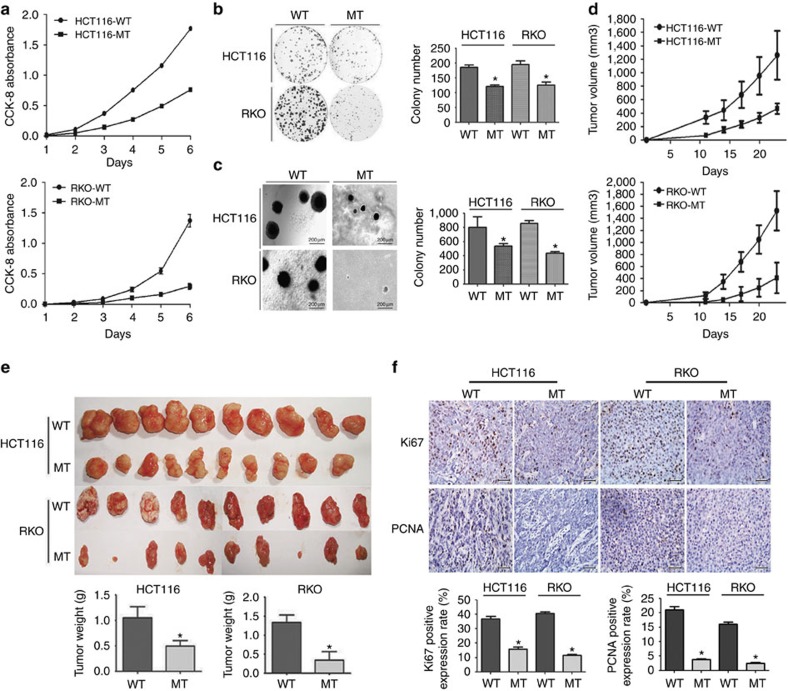
The effect of RHBDD1 inactivation on tumorigenesis in vitro and in vivo.(a) Cell proliferation assays. The samples were assayed in triplicate. Each point represents the mean value from three independent samples. (b) Colony formation assays and (c) soft agar colony formation assays. Representative photographs and bar graphs are from three independent experiments. The data are presented as means±s.d., N=3, the Student's two-tailed t-test, *P<0.05. (d) Growth curves of xenograft tumours. Tumor volumes were monitored every 3 days by measuring tumor diameters. The data are presented as means±s.d., N=10. (e) Images and weights of xenograft tumours. The tumours were removed, photographed and weighed. The bar graphs represent means±s.d., N=10, the Student's two-tailed t-test, *P<0.05. (f) Immunohistochemical analysis of xenograft tumours. Xenograft tumours were immunostained to detect Ki67 or PCNA expression (scale bar, 50 μm). The bar graphs represent semi-quantification of Ki67- and PCNA-positive cells from 4 different groups (means±s.d., N=6, the Student's two-tailed t-test, *P<0.05).